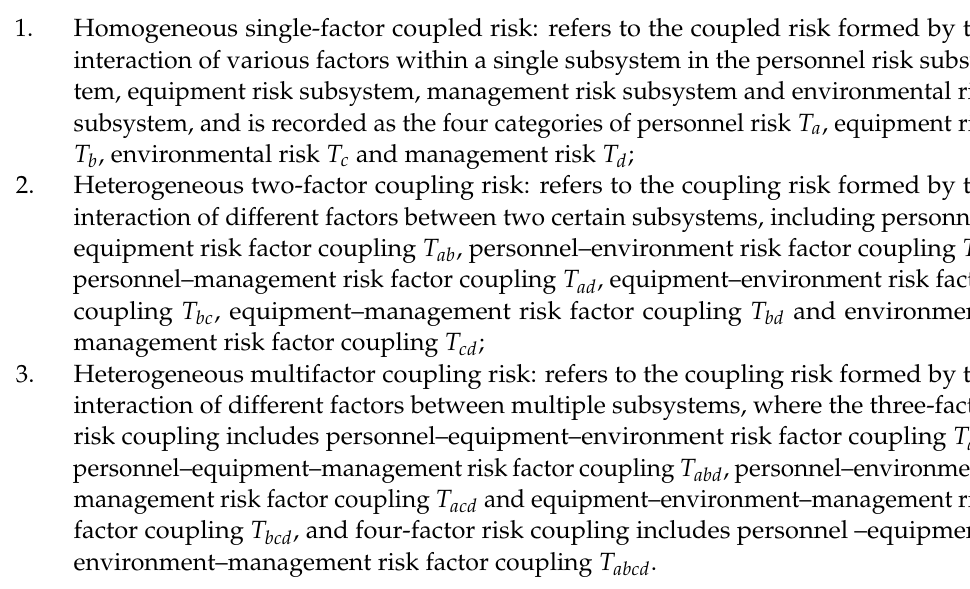
Figure 4. Tunnel construction safety risk factor coupling